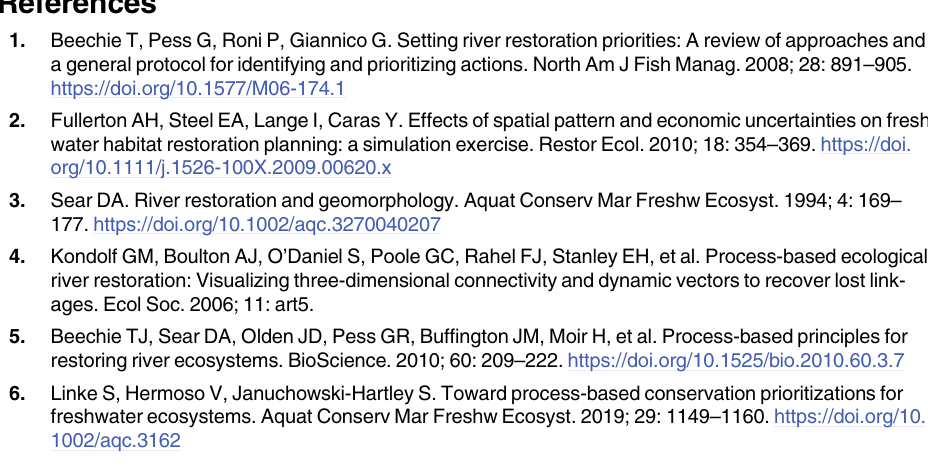
S3 Table. Beaver pond densities. Estimated pond densities from maps and data showing cal- culation of weighted mean natural potential beaver ponds per km in the Chehalis basin [1]. Number of ponds is the manually-counted number of dam symbols in each subbasin from the published